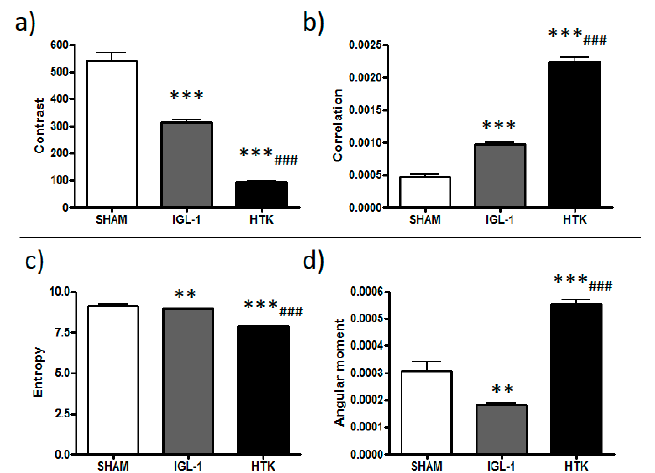
Figure 2. Parameters obtained after a co-occurrence matrix analysis of confocal microscopy images (Figure 1d (SHAM), Figure 1e (IGL-1), Figure 1f (HTK)). Bar graphs represents contrast ( a ), correlation ( b ), entropy ( c ) and Angular moment ( d ) mean ± SD, ** p < 0.005 vs. SHAM, *** p < 0.0005 vs. SHAM, ### p < 0.0005 vs. IGL-1.